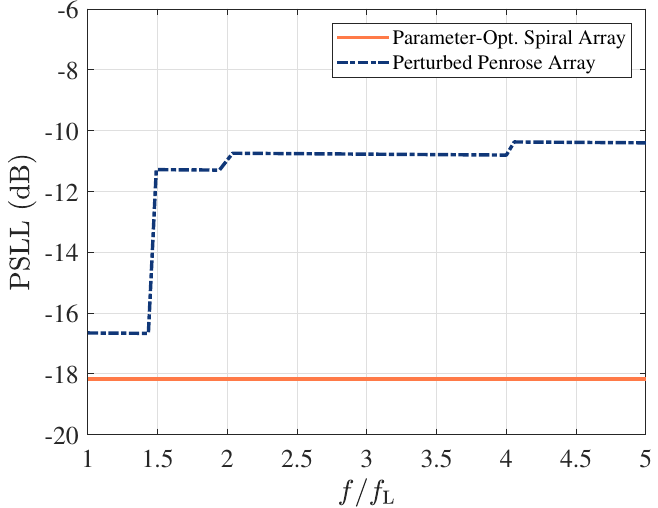
Figure 6. PSLL results of perturbed Penrose array [12] and parameter − optimized spiral